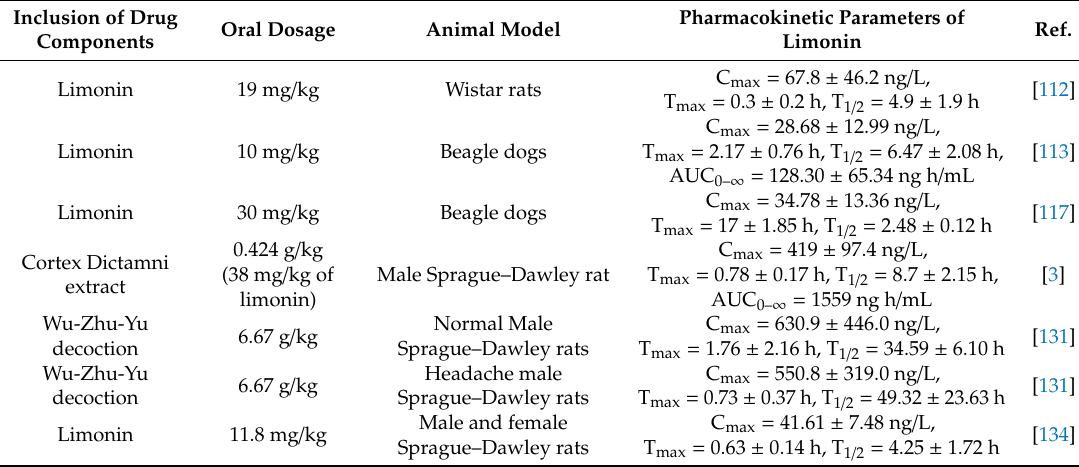
Table 4. Pharmacokinetic parameters of limonin in animals after oral administration. Inclusion of Drug